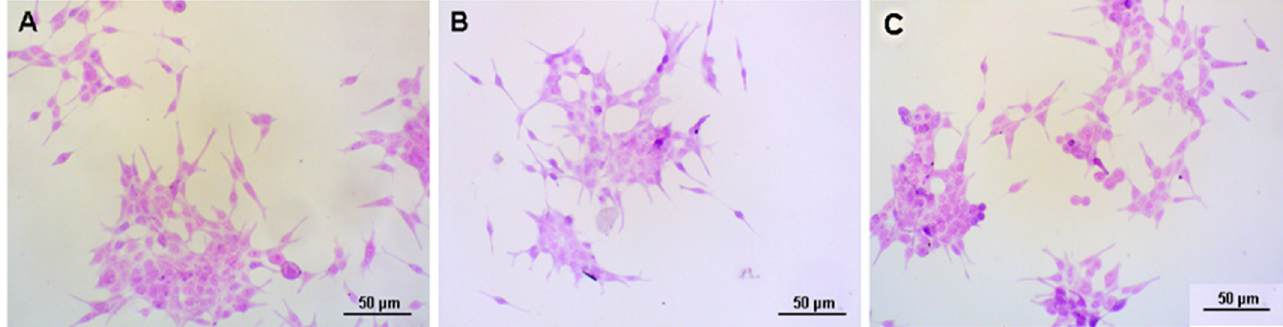
Figure 1. Representative images of LNCaP cells stained with Hematoxylin-Eosin. ( A ) untreated LNCaP cells. ( B ) LNCaP cells exposed to bacteriophage M13 at 1 × 10 7 pfu/mL. ( C ) LNCaP cells exposed to bacteriophage T4 at 1 × 10 7 pfu/mL. No significant morphological difference was observed between the treated and untreated cells after 24 h of treatment. Scale bars = 50 μ m.